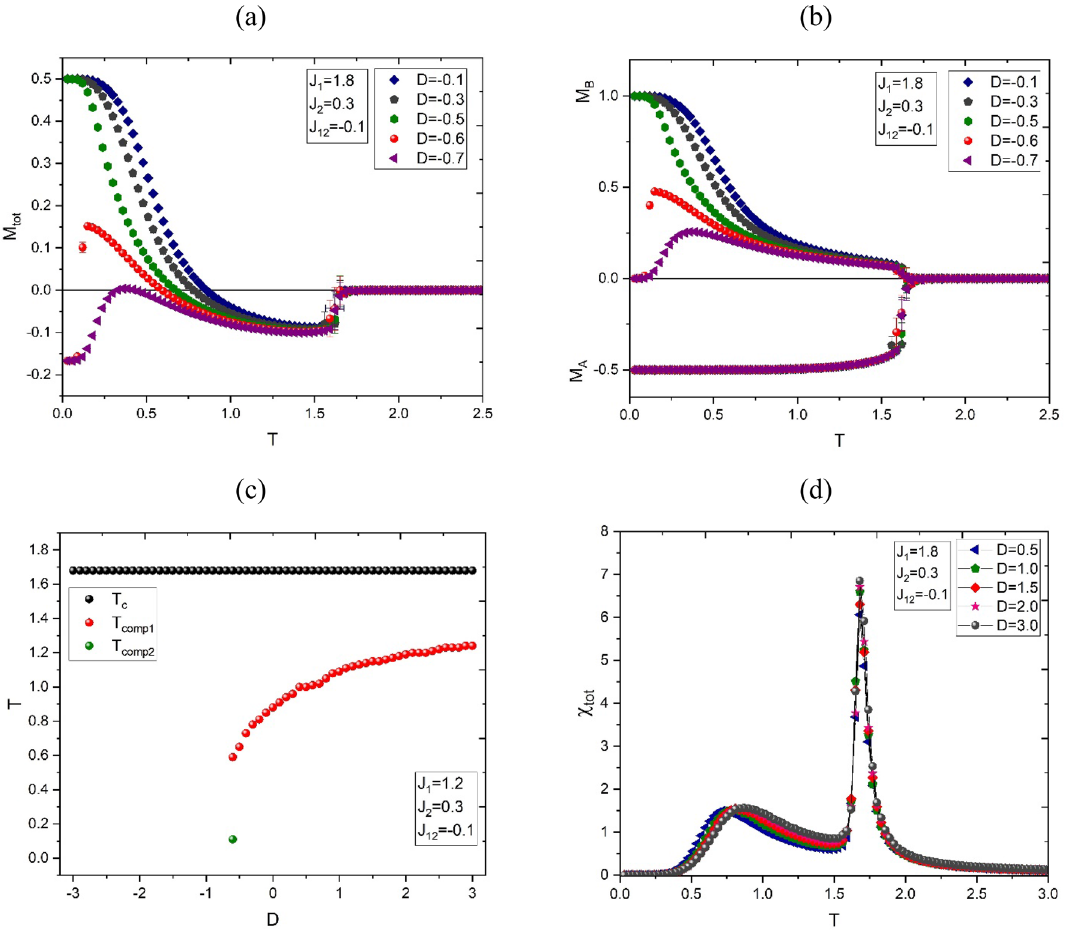
Fig. 5 Effect of D on a total magnetization, b sublattices magnetization, c critical and compensation temperature, and d total susceptibility of the system at fixed J 1 = 1.8, J 2 = 0.3, J 12 = − 0.1.